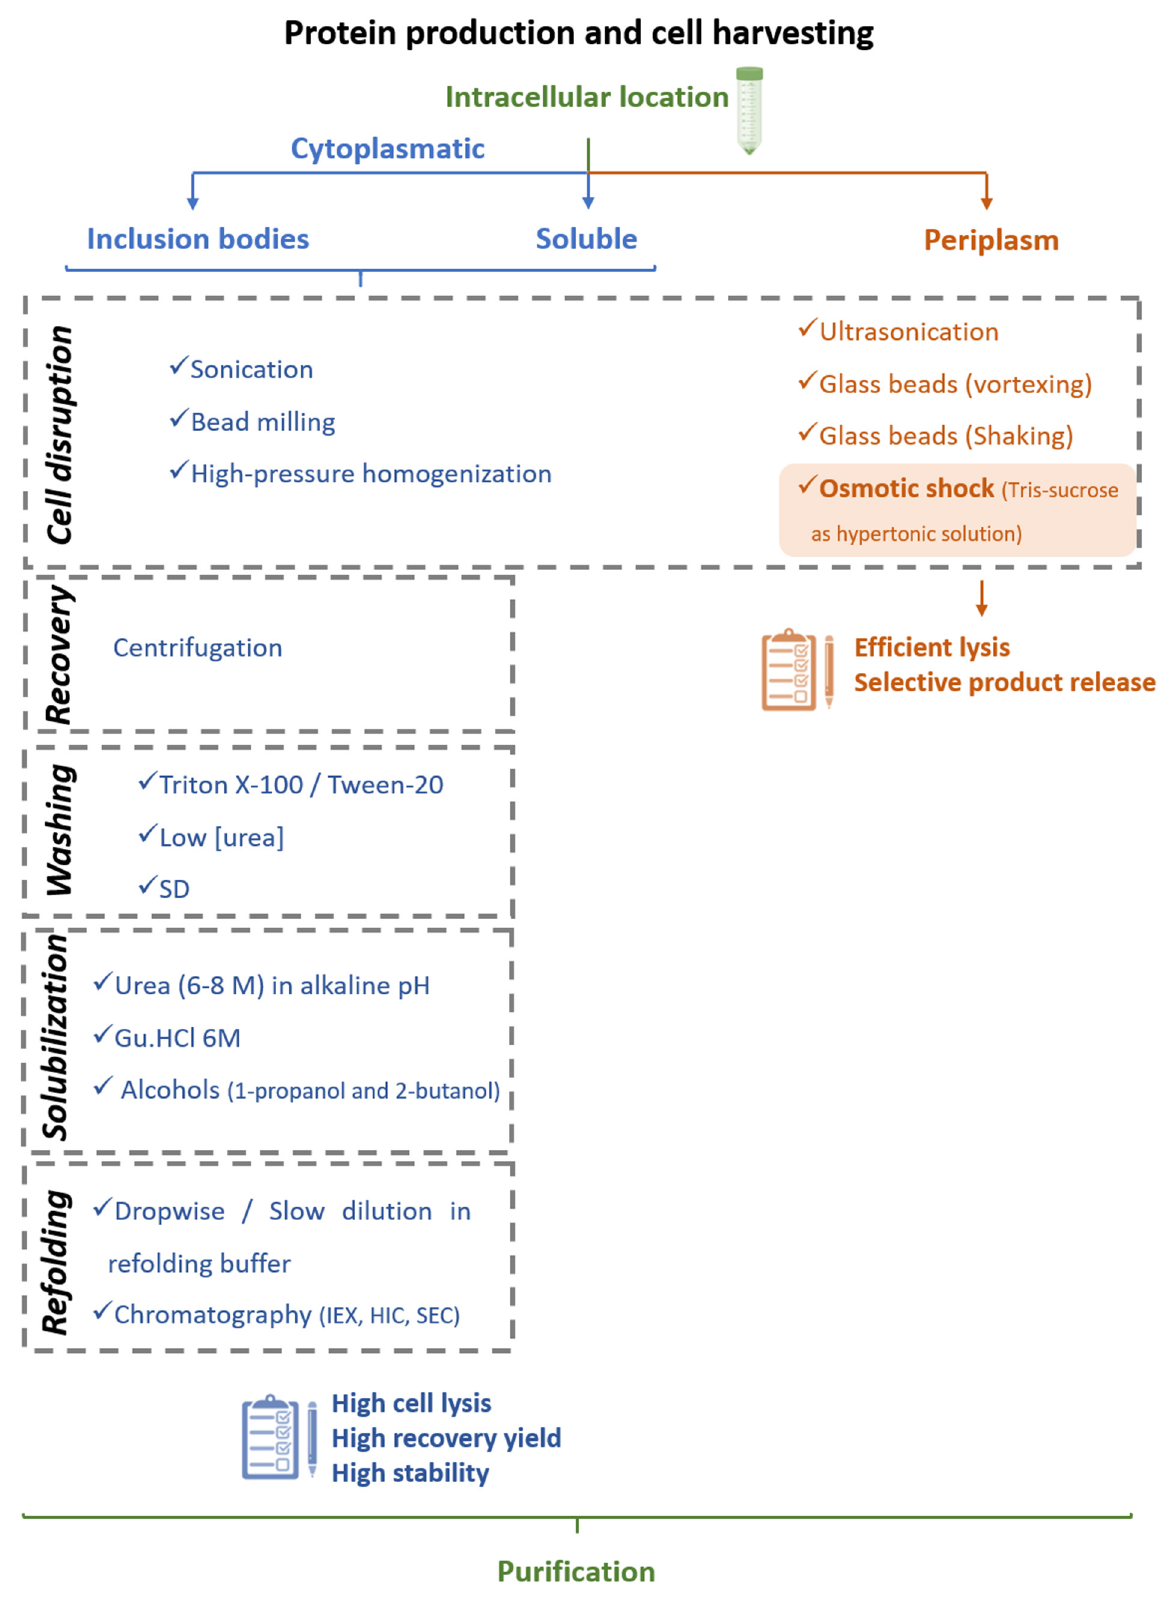
Figure 5. Primary recovery strategies for E. coli derived IFNs.